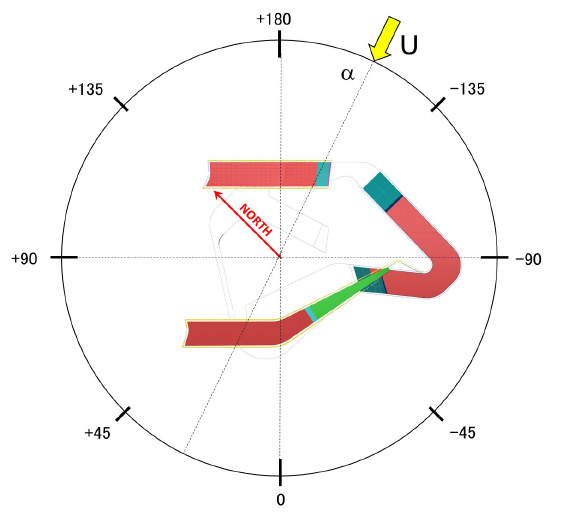
Figure 5. Wind direction convention. Red arrow shows the true North direction. Multi-hole cobra probes were used to measure the three-components of the velocity vector in the gap in the PDSF. These sensors were installed in the gap between the perforated metal and the inner skin as well as in front of the external side of the porous façade. To achieve a reliable estimation of the gap flow, cobra probes were mounted pointing towards the expected direction of the